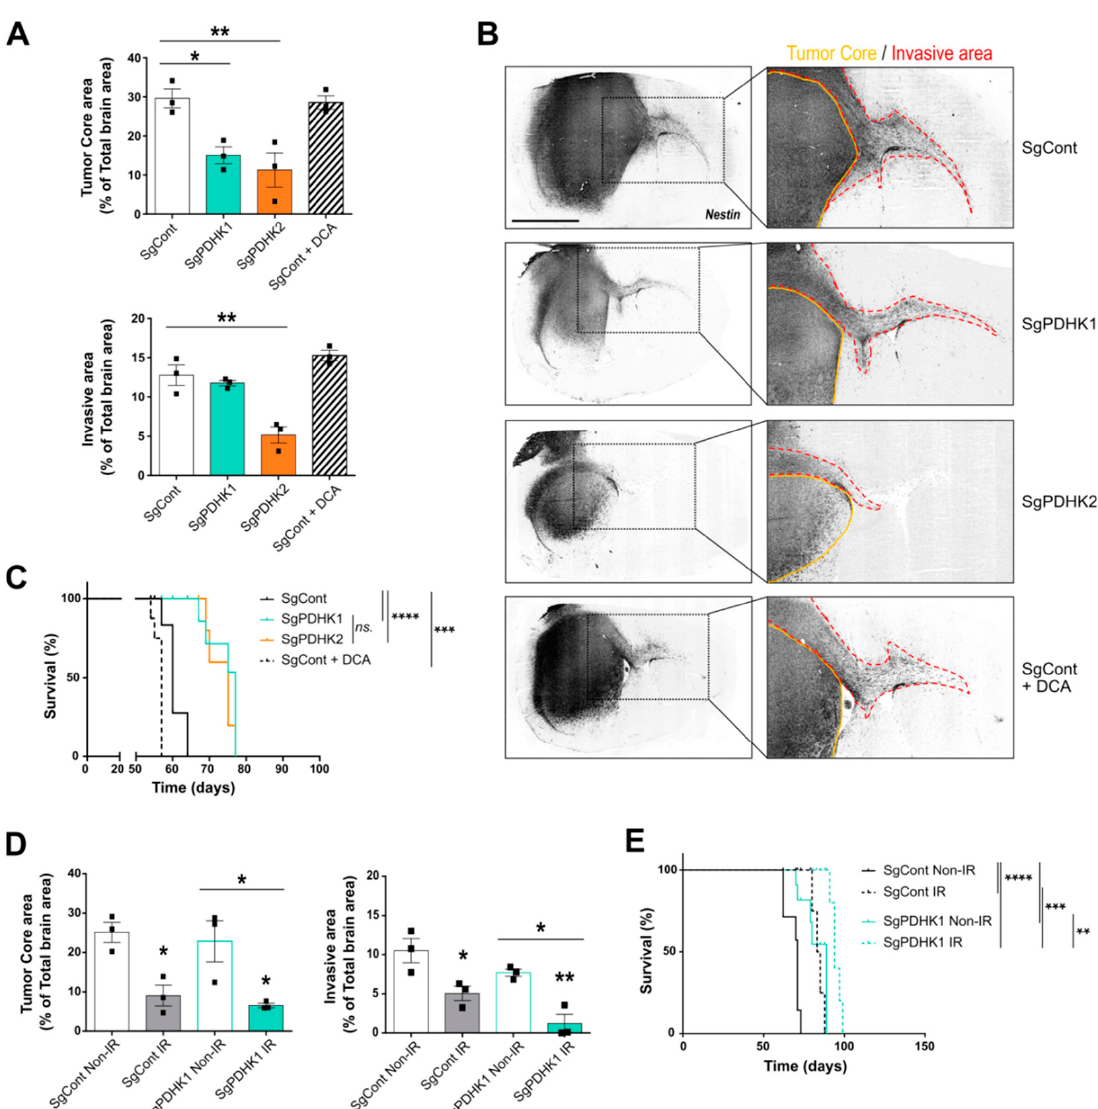
Figure 5. PDHK1 and PDHK2 KO reduce in vivo tumor growth and improve mice survival. ( A ) Tumor core and invasive areas were calculated in control, PDHK1 KO, PDHK2 KO and DCA-treated tumors based on mouse brain slices. ( B ) Right panel: histological analysis and staining with a human anti-nestin antibody (dark grey staining); left panel: magnified images showing contralateral invasion (red dashed lines). ( C ) Kaplan–Meier survival curves of xenotransplanted mice with P3 cells KO for PDHK1 (green), PDHK2 (orange), DCA-treated (dashed line) or control (black) ( n = 5 to 8 mice per group). ( D ) Tumor core and invasive areas were calculated in control and PDHK1 KO tumors, irradiated (IR, 3 × 2 Gy) or not (Non-IR). ( E ) Kaplan–Meier survival curves of xenotransplanted mice with P3 cells KO for non-irradiated PDHK1 (green), or irradiated PDHK1 (green dashed line), or non-irradiated control (black) or irradiated control (black dashed line) ( n = 4 to 7 mice per group). Data are expressed as the mean ± SEM, and p-values were obtained using one-way ANOVA ( A , D ) or log-rank (Mantel–Cox) test ( C , E ); * p < 0.05; ** p < 0.01; *** p < 0.001; **** p < 0.0001; ns. : not significant.